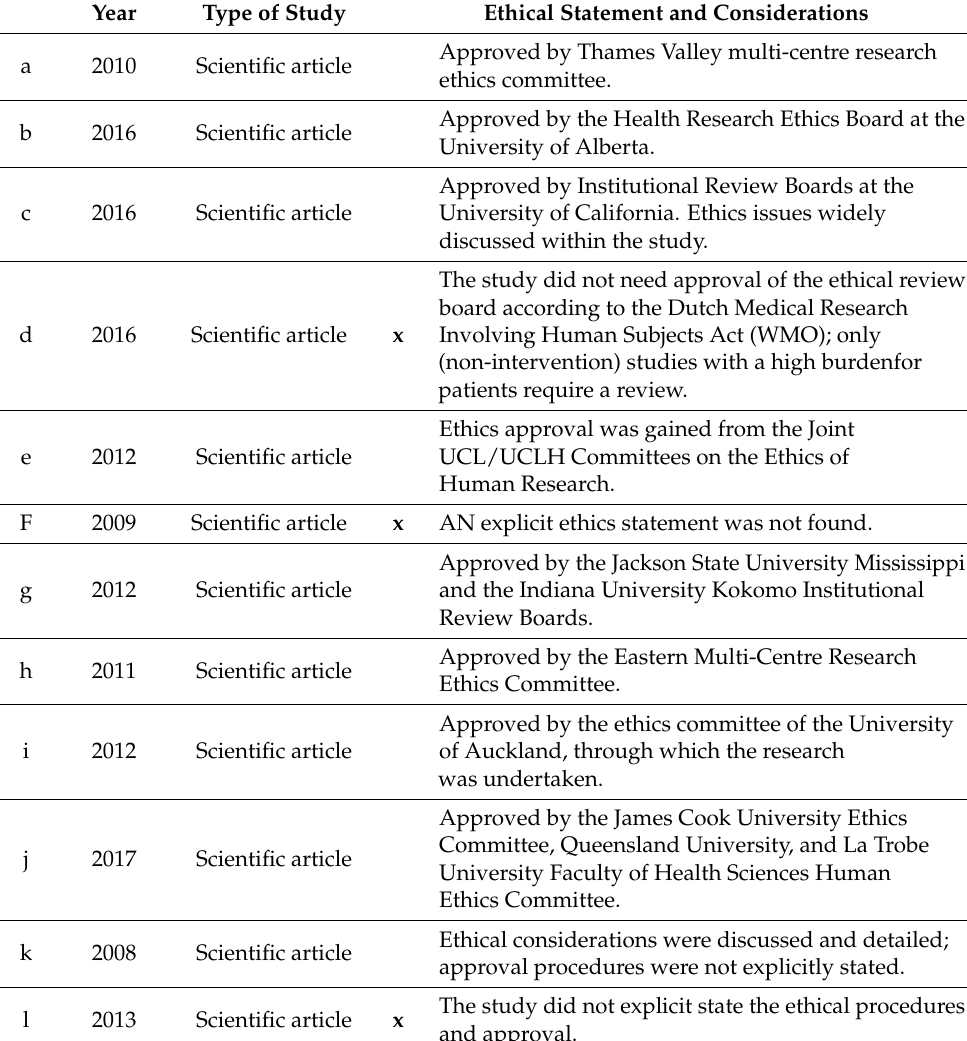
Table 2. Studies included, characteristics, and ethical